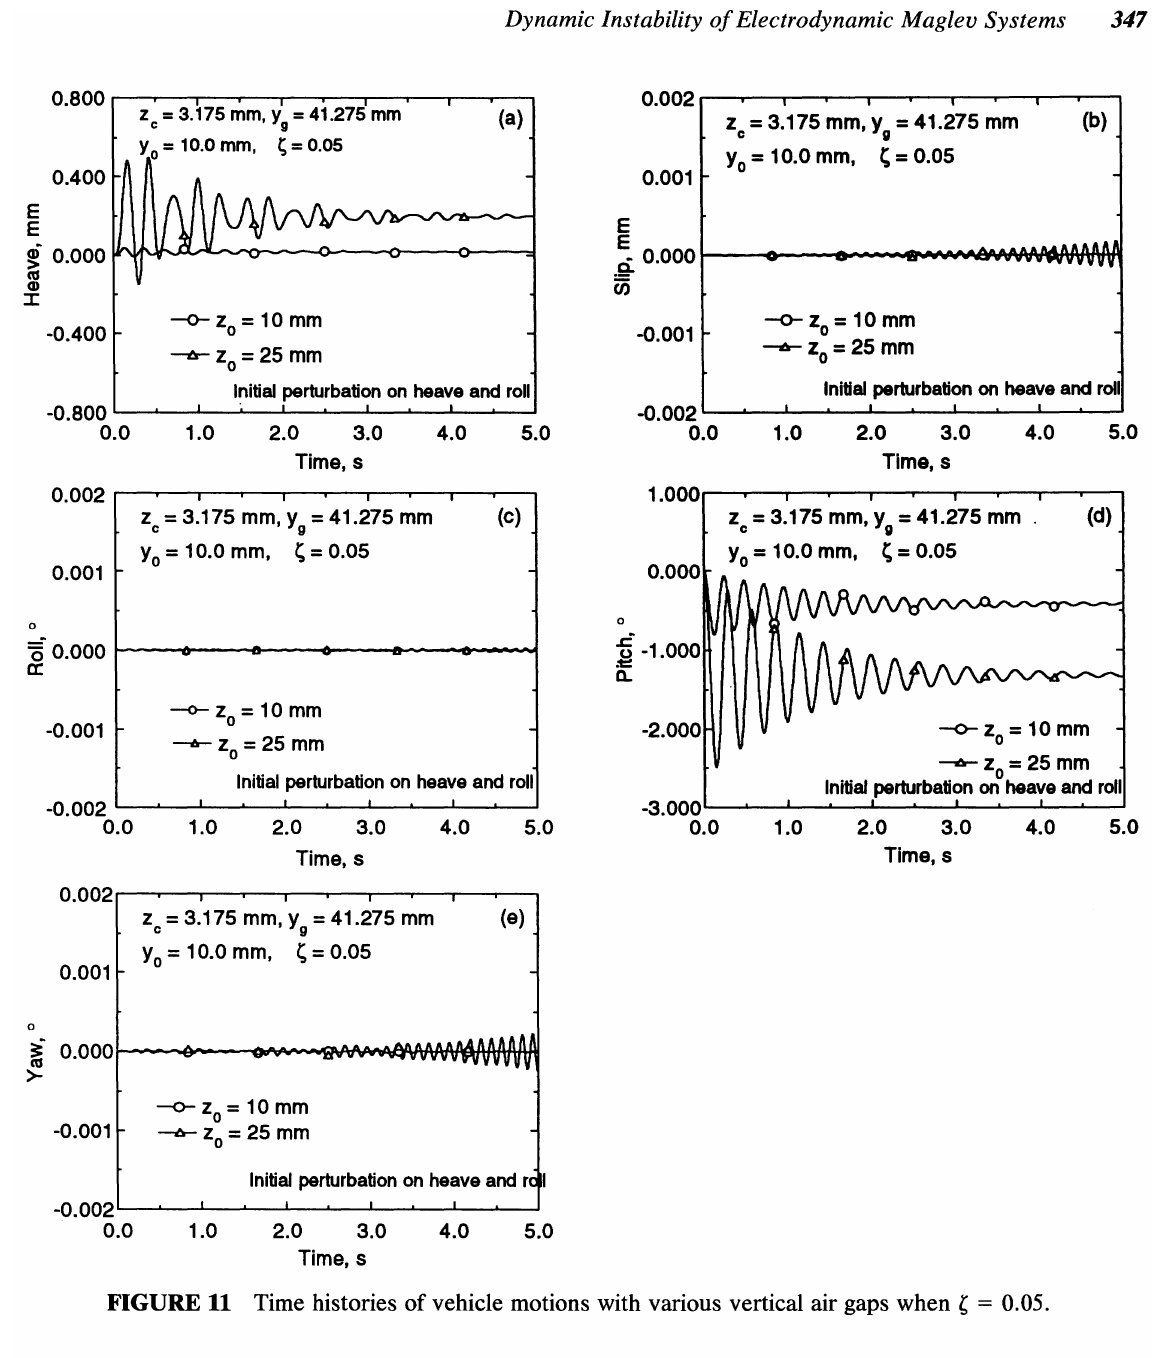
In Figure 12, the center of gravity is changed to Zc = 0.0 mm. In this case, with, = 0.01, heave perturbation causes flutter only in heave motion [Fig. 12(a)], and roll perturbation causes flutter only in roll motion [Fig. 12(c)]. Slip perturbation causes flutter in both slip and yaw motions [(Fig. 12(b,e)], while in Figs. 9 and 10, one-direction perturbation can cause instabilities in several mo tions. We can even find the frequency of coupled motion [Figs. 9(a) , lO(a) , and 10(c)]. It can